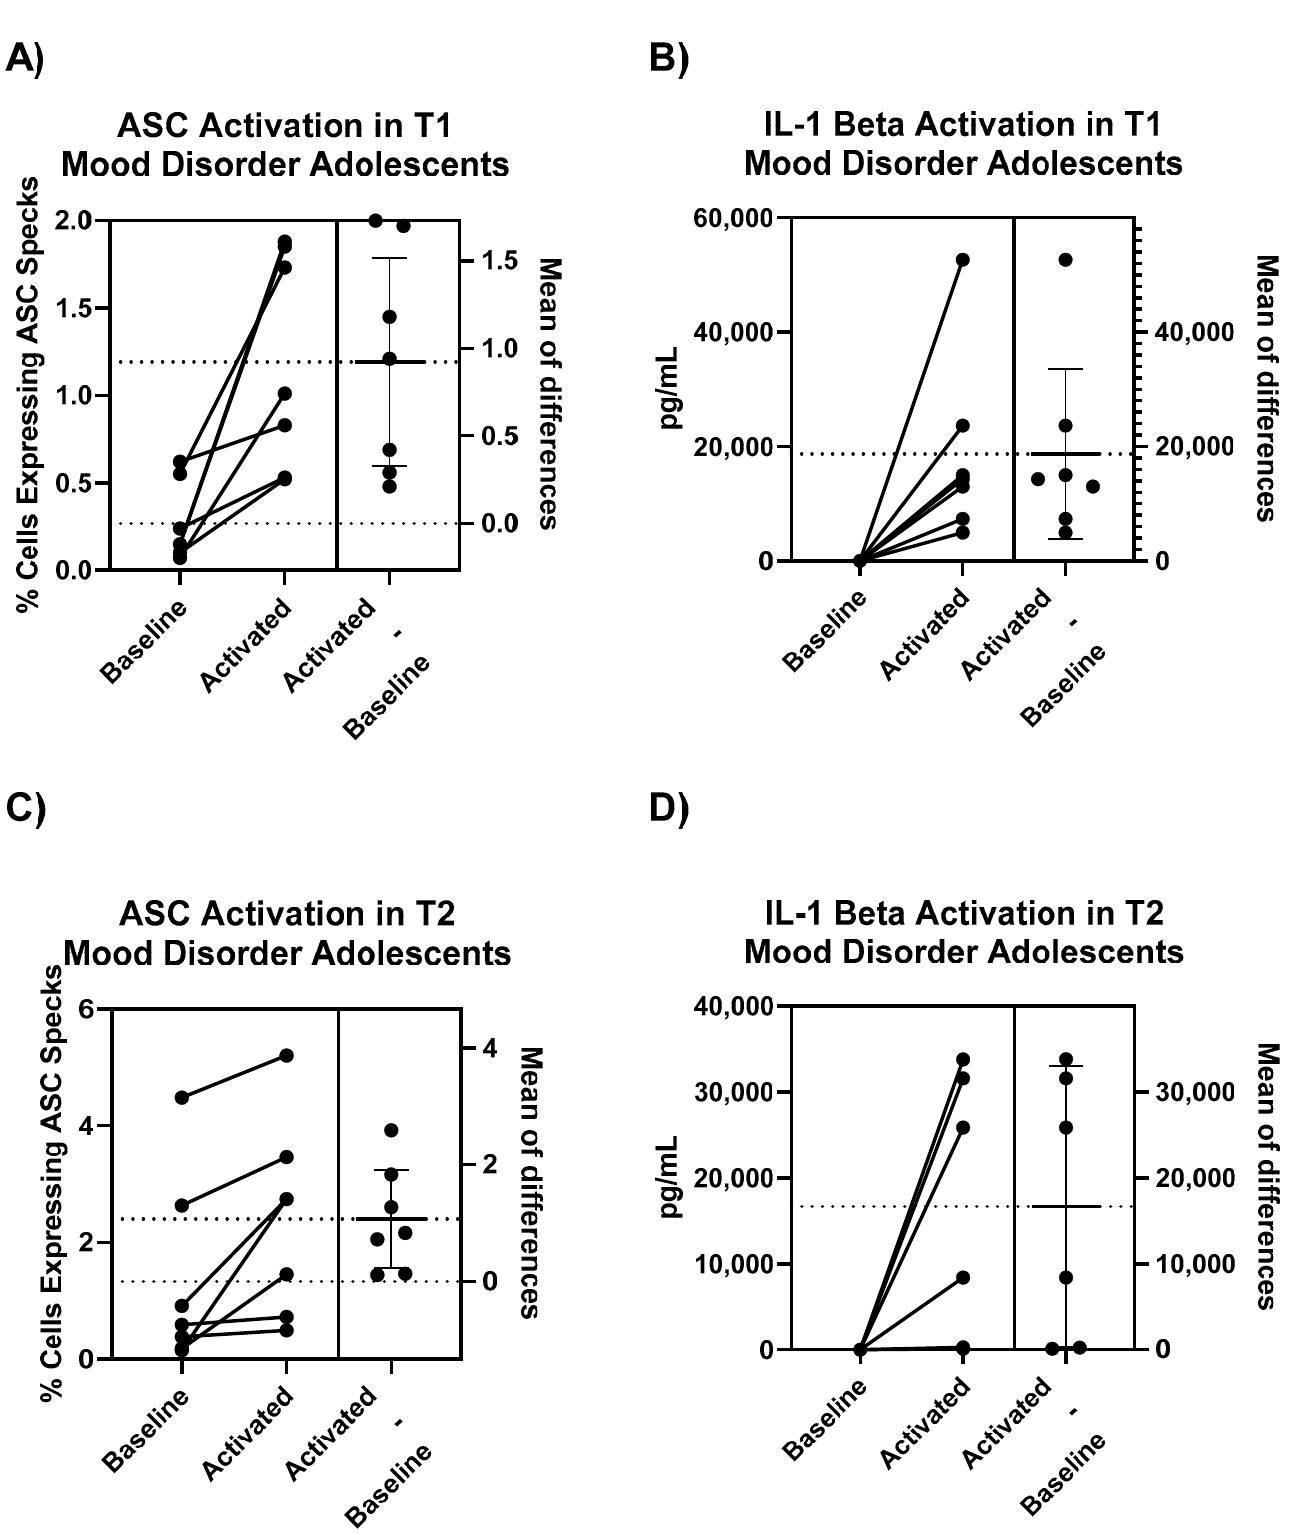
Figure 3. Paired t -test results demonstrating activation of ( A ) ASC and ( B ) IL-1 beta in untreated PBMC of adolescent mood disorder patients compared to LPS and nigericin activated PBMC from the same patient. Results from the T2 visit 6 months later for ( C ) ASC and ( D ) IL-1 beta were also measured. ASC values are intracellular and measured using immunofluorescence while IL-1 beta values are extracellular and measured using ELISA. Mean of differences are expressed as mean ± SD, all paired t -tests were statistically significant for p < 0.05.